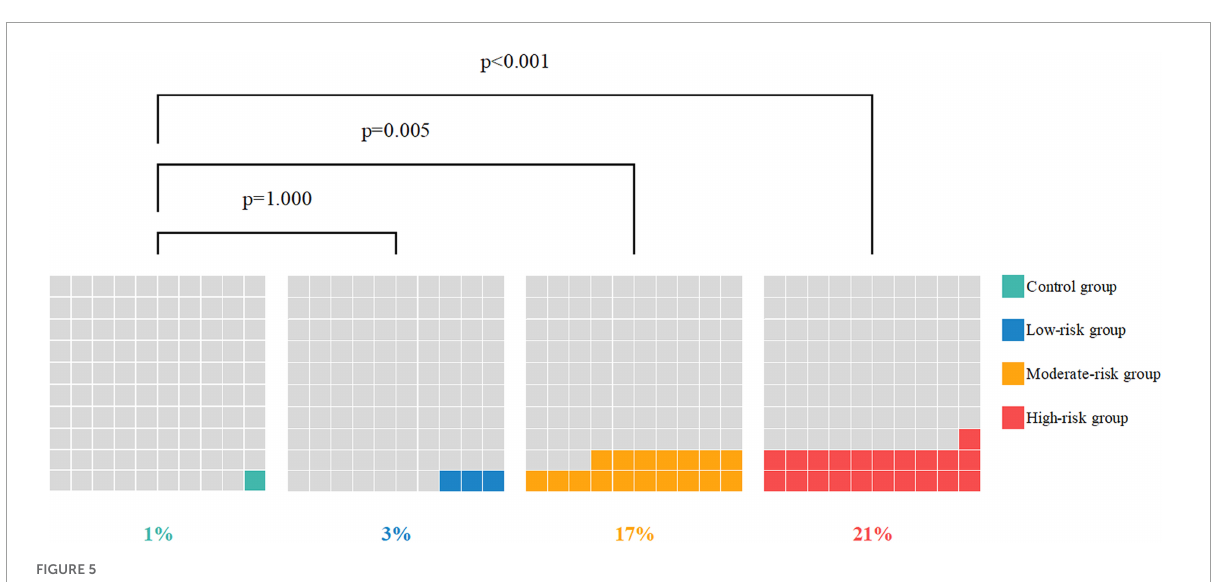
FIGURE5 The SPP-positive ratio of the control group and DM